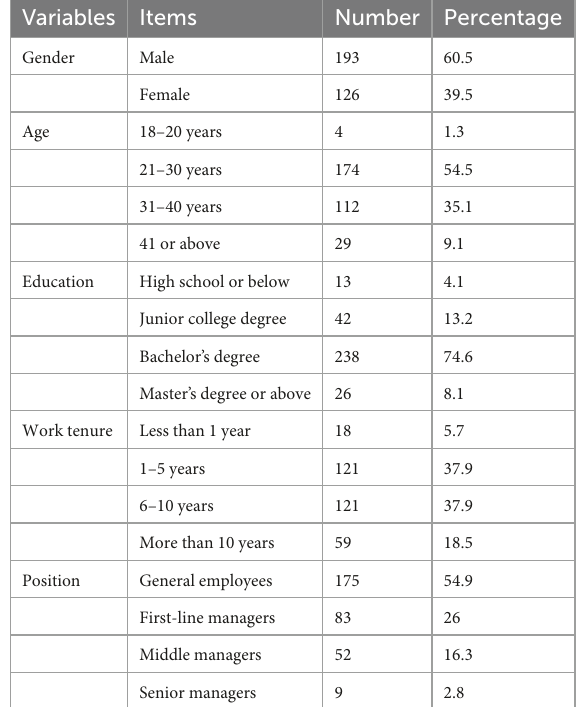
TABLE 1 Demographics of the samples ( N =